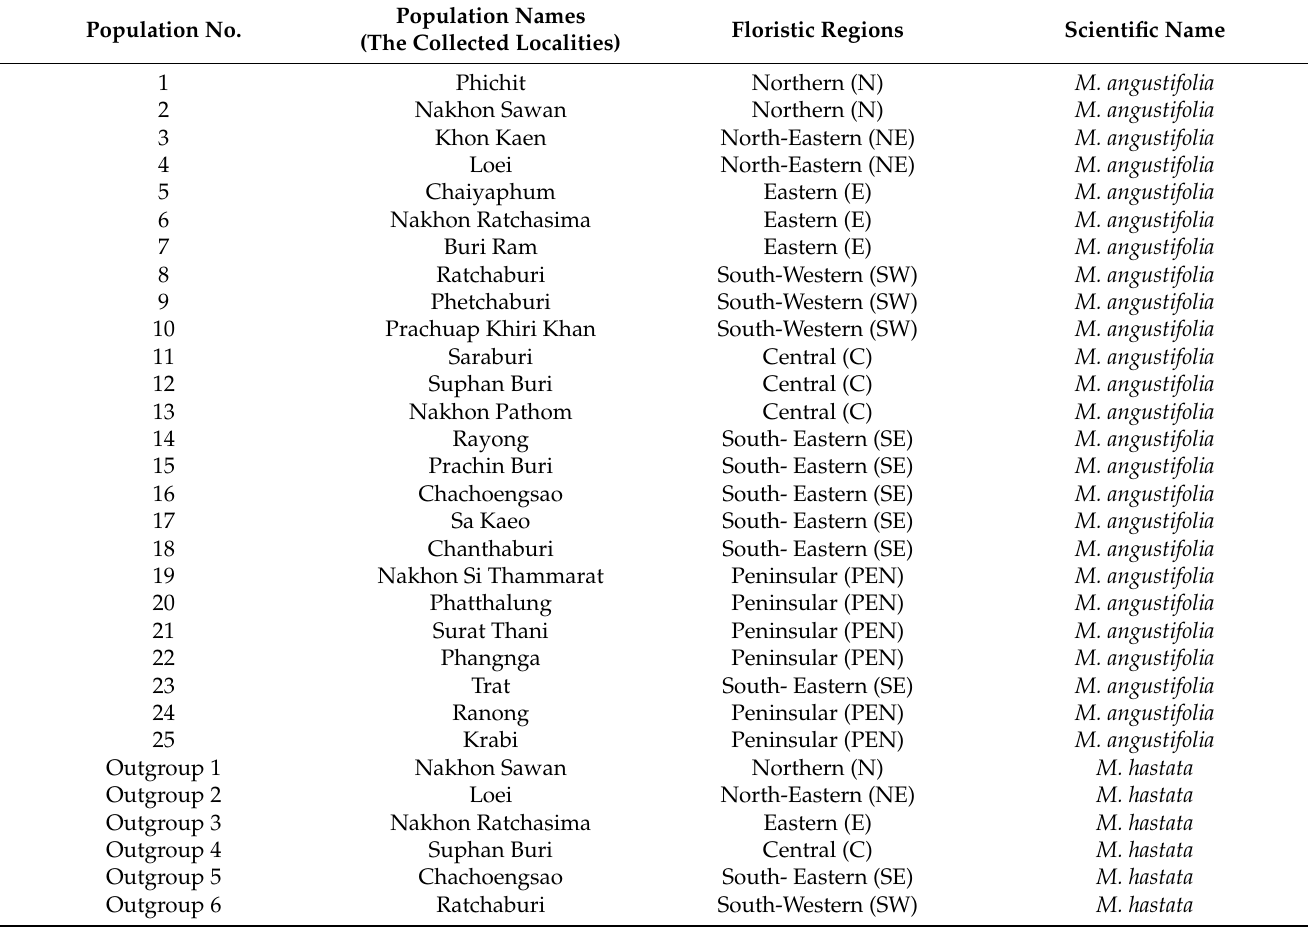
Table 1. The collected 25 populations of the new species, M. angustifolia and outgroup ( M. hastata ). Population